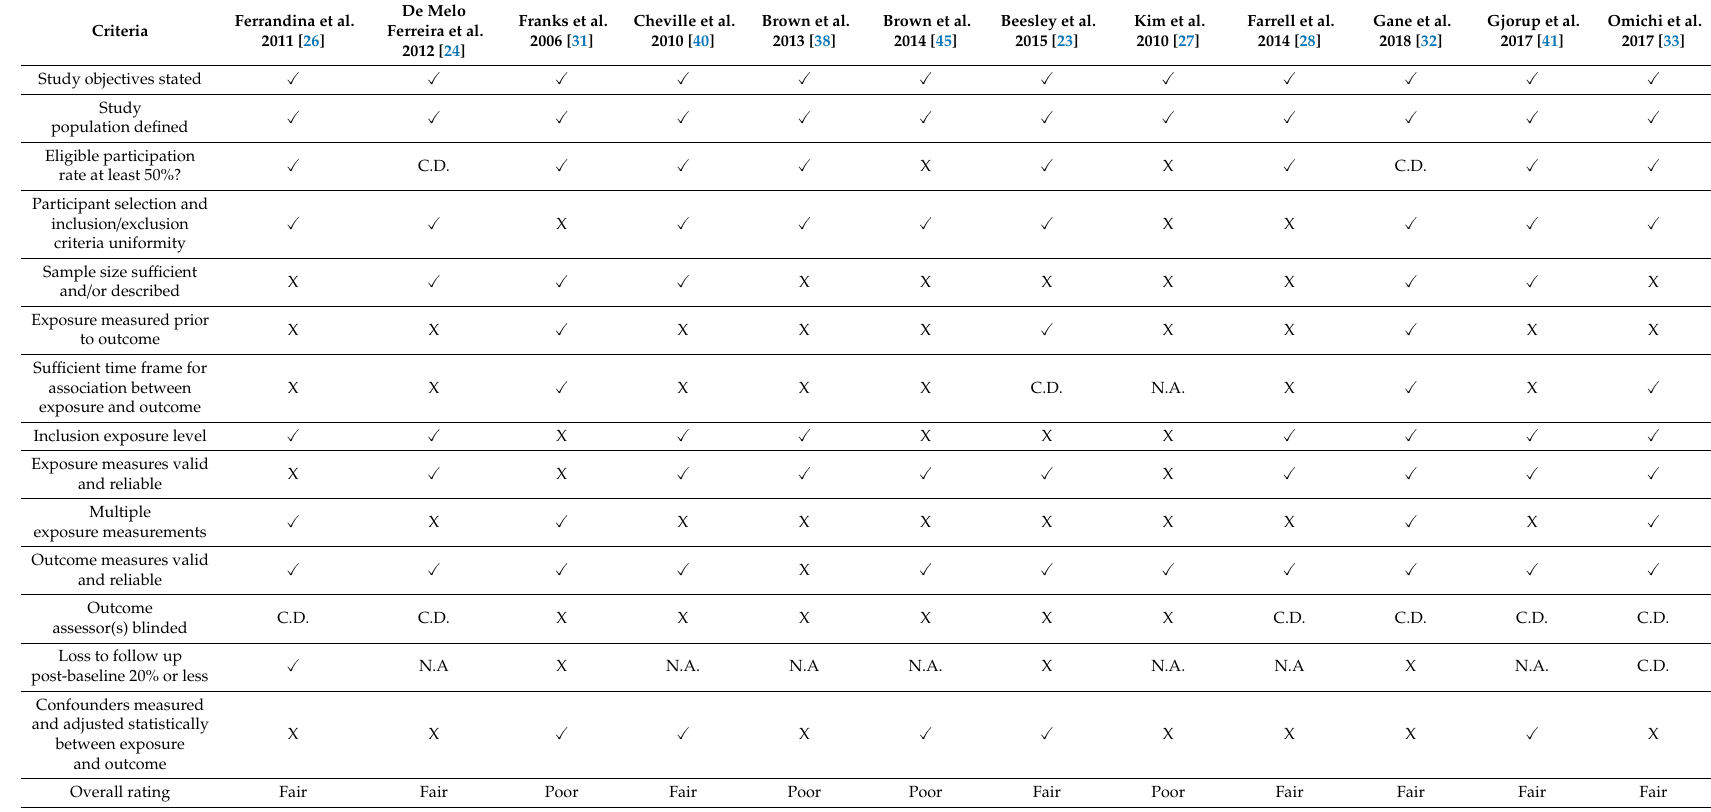
Table 3. NIH Quality Assessment for Observational Cohort and Cross-Sectional Studies II.